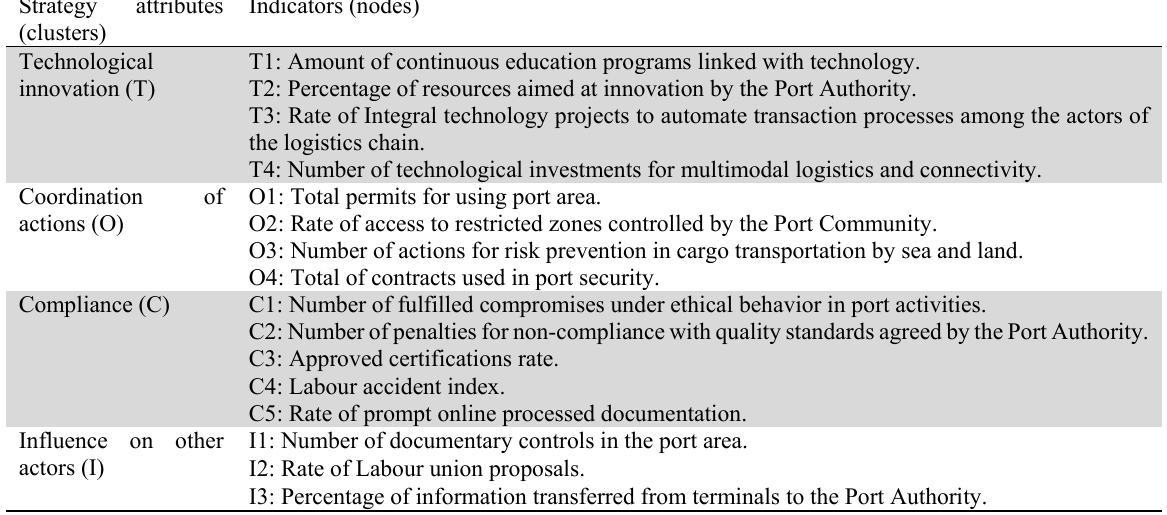
Nodes or strategic/operational indicators, in the technological and risk